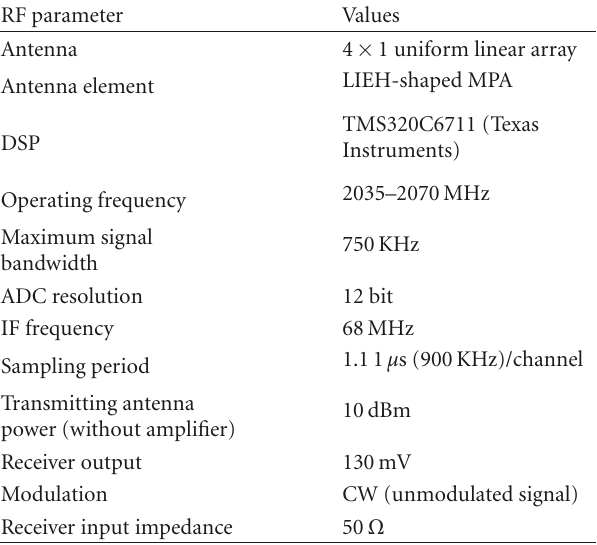
Table 3: Specification of UKM testbed receiver.